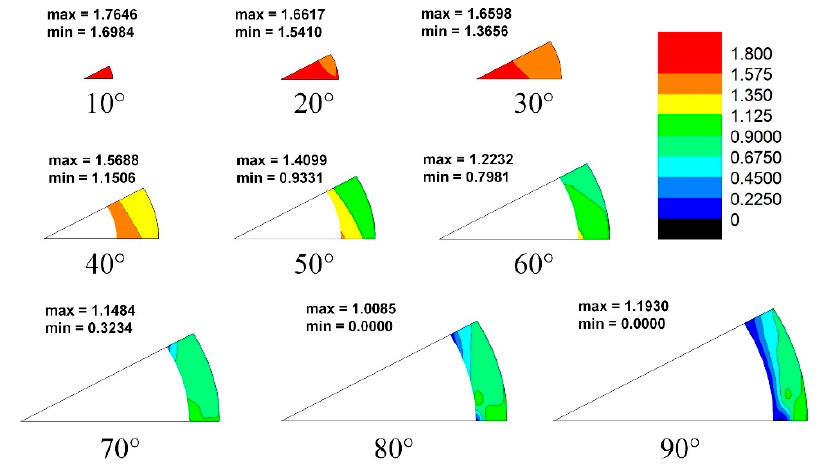
Figure 10. Misorientation distribution map of Mg–8.0Gd–3.0Y–0.5 Zr alloy.